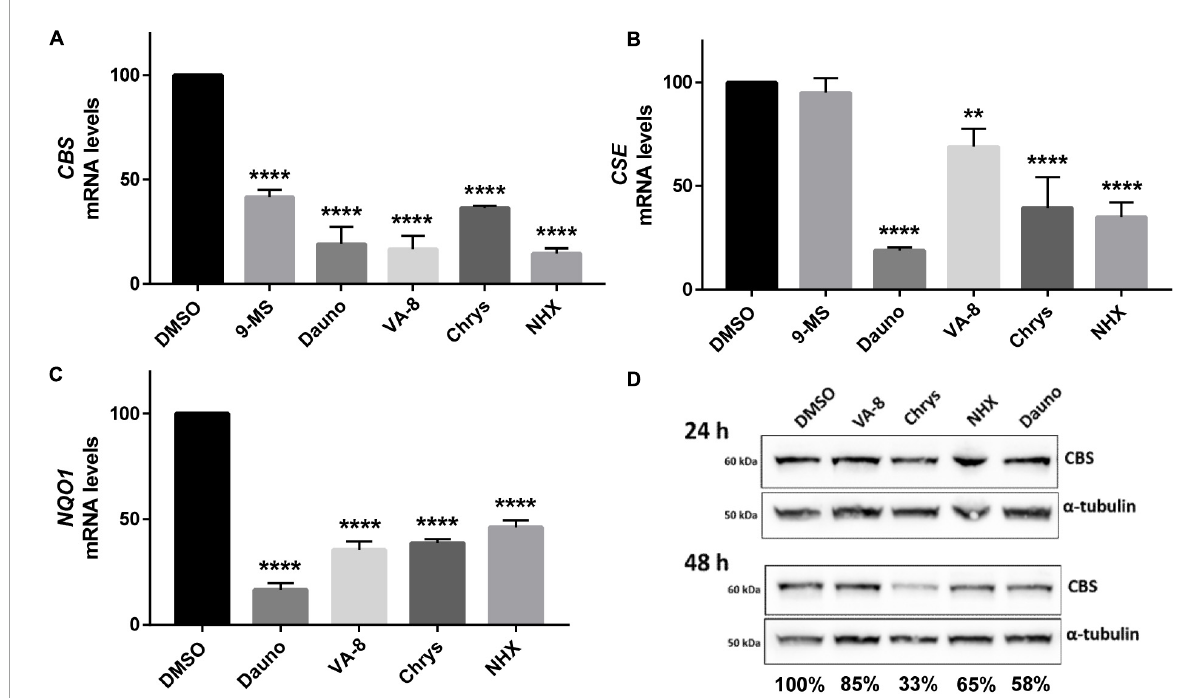
FIGURE4 Effect of molecules identified in the pharmacological screening on Cystathionine beta synthase (CBS) , cystathionine γ lyase (CSE) and NQO1 mRNA and CBS protein levels. (A–C) The level of CBS (A) , CSE (B) , and NQO1 mRNAs: three genes involved in the defense against oxidative stress and which are regulated by the NF- κ B and the Akt/GSK3 β pathways, was assessed by RT-qPCR 24 h after treatment with 30 µ M of 9-methylstreptimidone, 150 nM of daunorubicin hydrochloride, 10 nM of 8 α -hydroxy-verrucarin A (VA-8), 200 nM of chrysomycin (Chrys) and 50 µ M of NHX in HepG2 cells. (D) Similarly, the level of CBS protein was assessed by western-blot 24 and 48 h after treatment with the same drugs. Ratios of CBS/ α -tubulin signals are indicated below each lane for 48 h fater treatment. (A–C) Comparison of each condition with DMSO, one-way ANOVA with Dunnett’s post-hoc test: ** p < 0.01; **** p < 0.0001. Note that there is no error bar for DMSO because the different values we obtained were expressed as percentages compared to the DMSO condition which was set up at